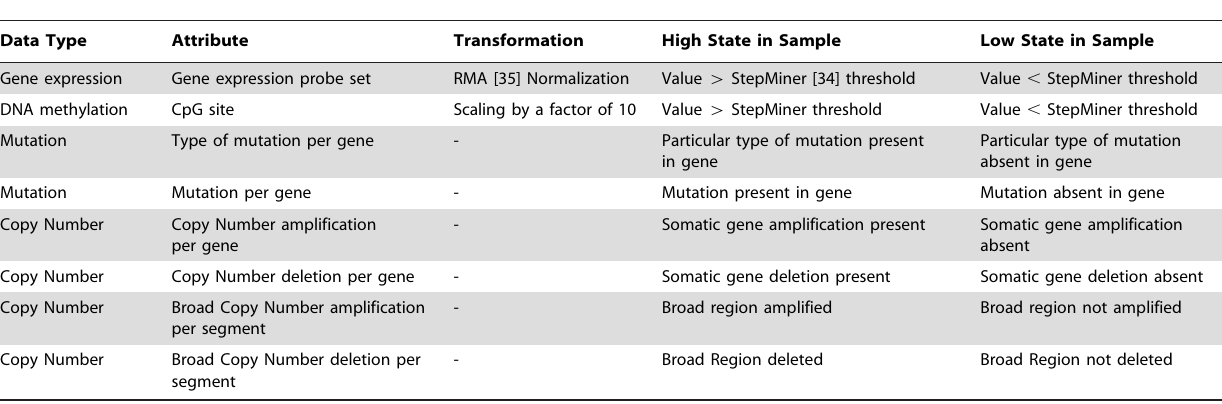
Table 1. Conversion of Different Data Types to High and Low States.